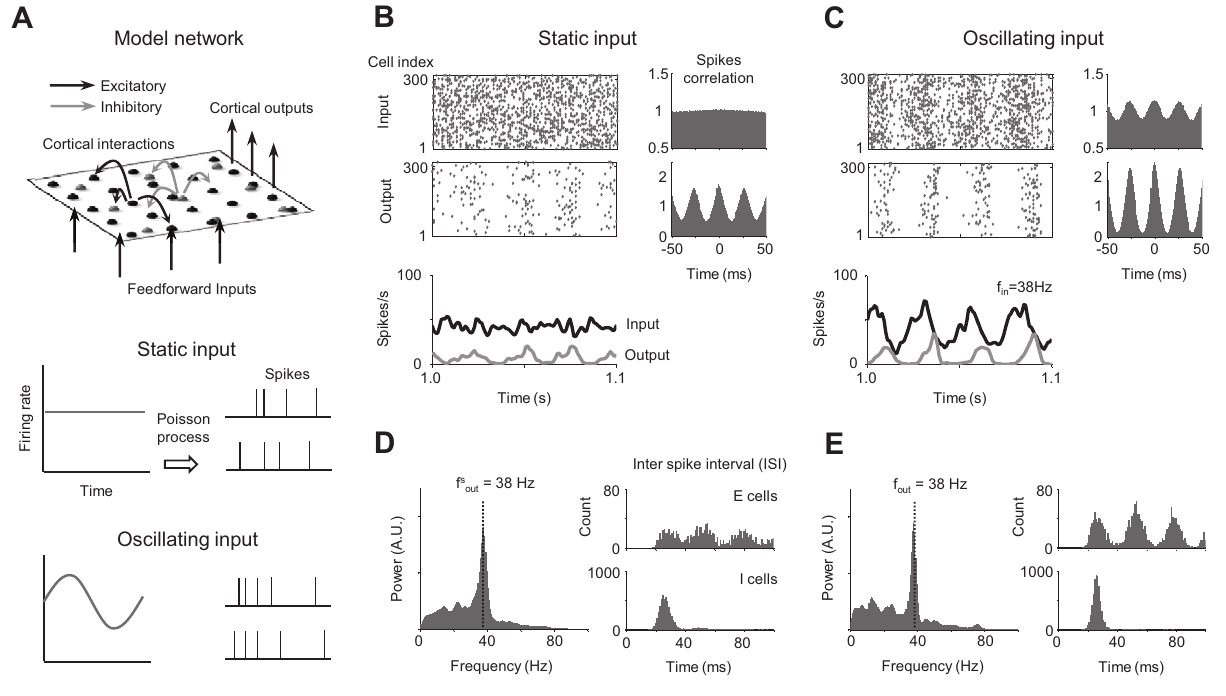
Figure 1. Synchronized population response to static and oscillating inputs. (A) The model visual cortex network. Each excitatory (E) and inhibitory (I) cell receives feedforward inputs from the thalamus, and cortical inputs from the other E and I cells within the range of lateral connections. (B) Population firing rates and spike correlograms for static input and (C) for sinusoidally oscillating input at 38Hz. Correlograms were normalized so that the uncorrelated state is set to unity. (D) Oscillation power spectrum of population firing rate and inter-spike interval (ISI) distribution for static input and (E) for oscillating input. Note that ISI distribution is sharper in (E) than (D), even though gamma oscillation frequencies are the same. For oscillation power spectrum, only the E cells result is displayed, because E and I populations showed identical peak